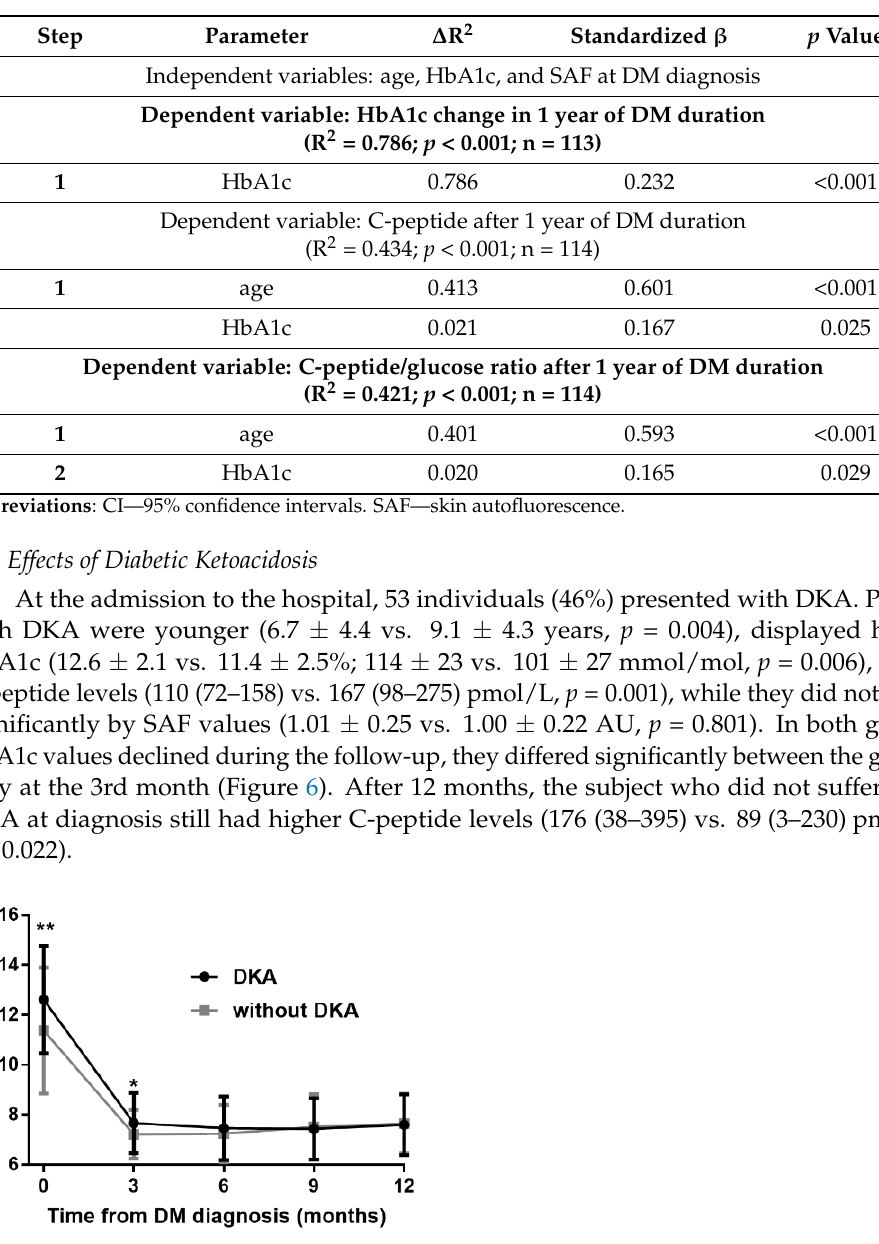
Figure 6. Concentrations of HbA1c during the first-year follow-up in patients who. manifested or did not manifest with DKA, *: p < 0.05, **: p < 0.01. Differences were calculated using the t -test. Data are expressed as mean ± SD.